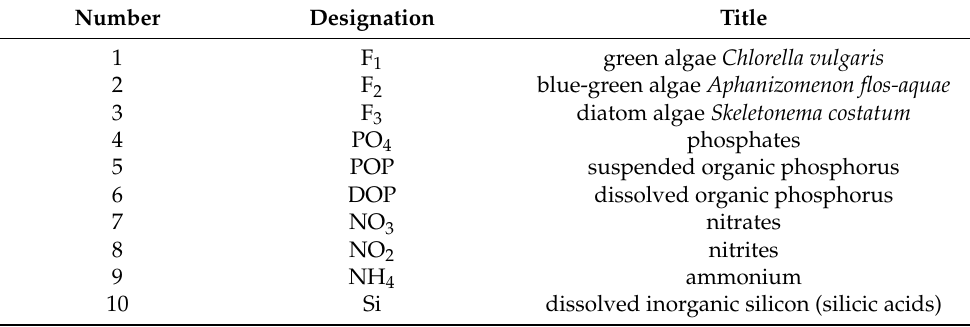
Table 1. Nutrients in the model dynamics of